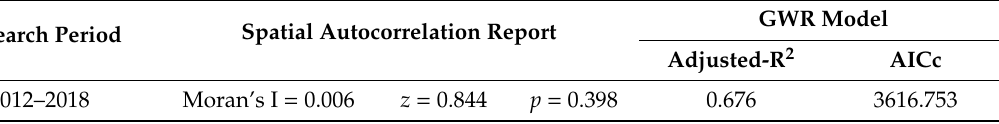
Table 4. Relevant parameters of the geographically weighted regression (GWR)